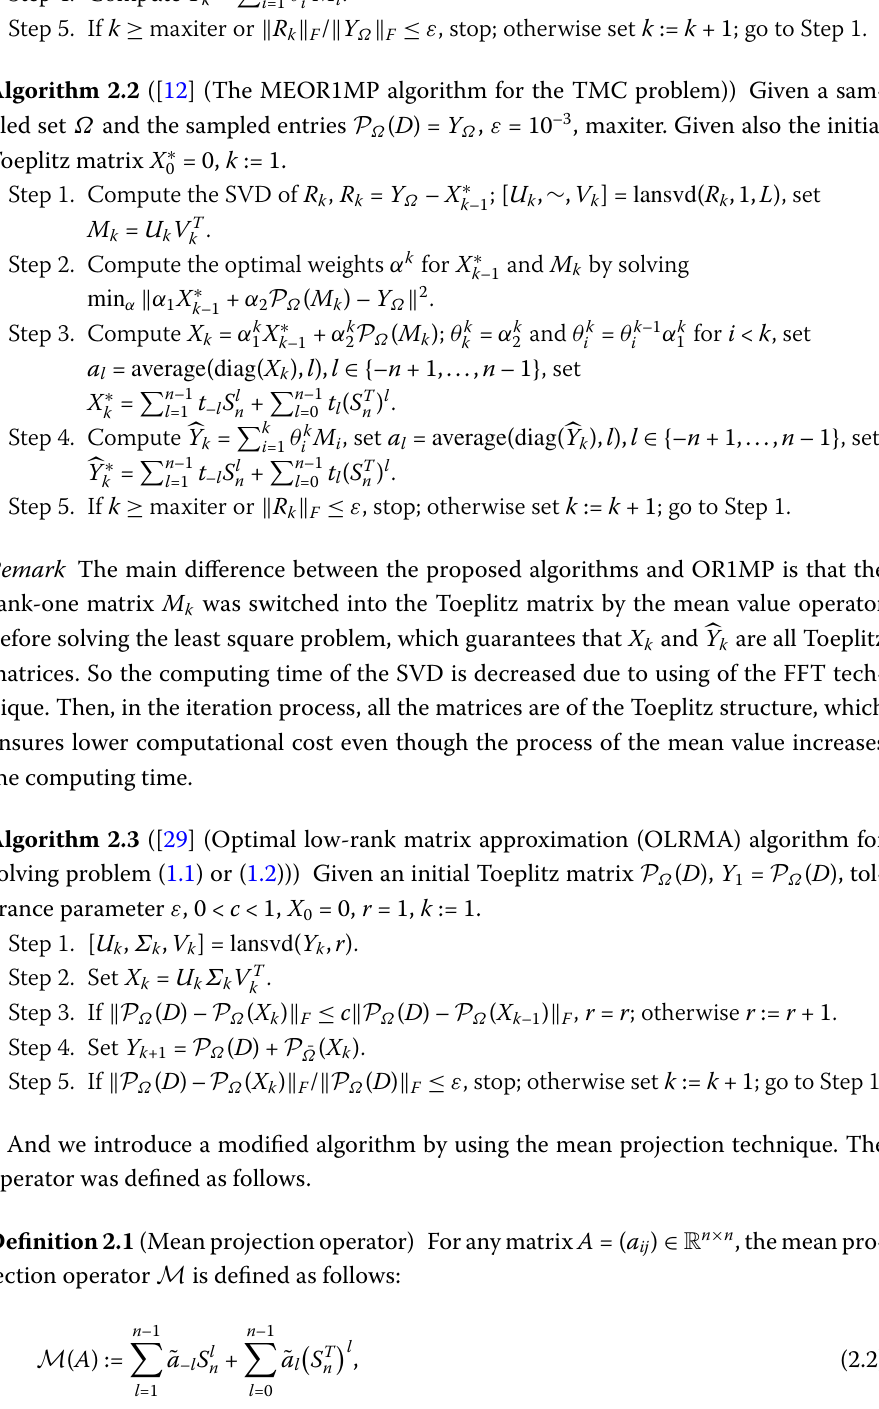
Algorithm 2.2 ([12] (The MEOR1MP algorithm for the TMC problem)) Given a sam- pled set Ω and the sampled entries P Ω ( D ) = Y Ω , ε = 10 –3 , maxiter. Given also the initial = 0, k := 1. Toeplitz matrix X ∗ 0